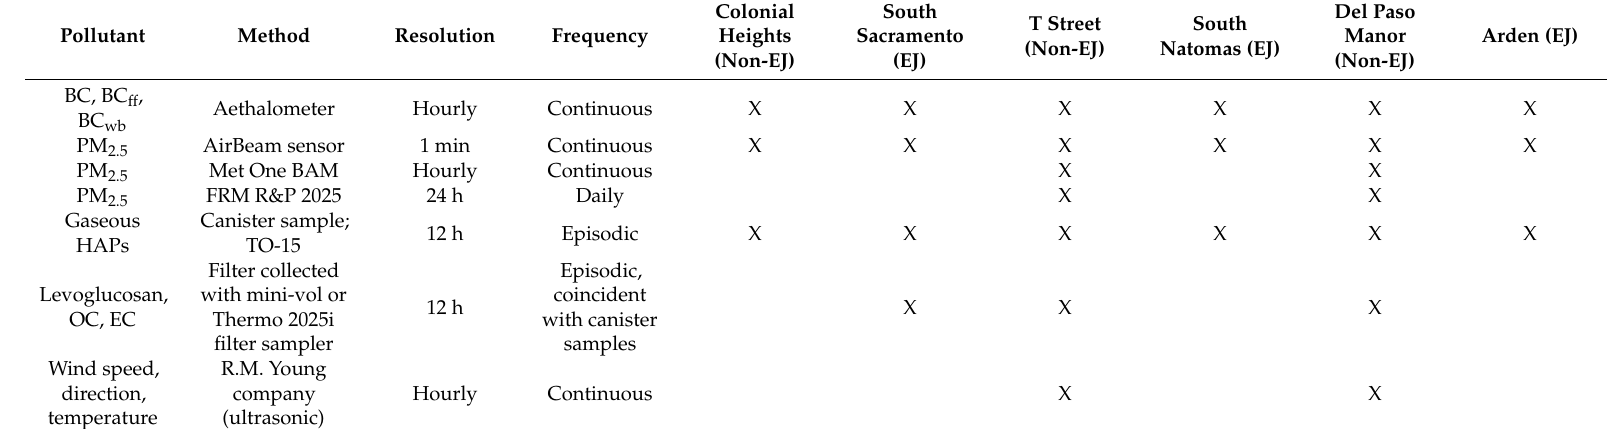
Table 1. Measurements conducted during the study period of 1 December 2016 through 31 January